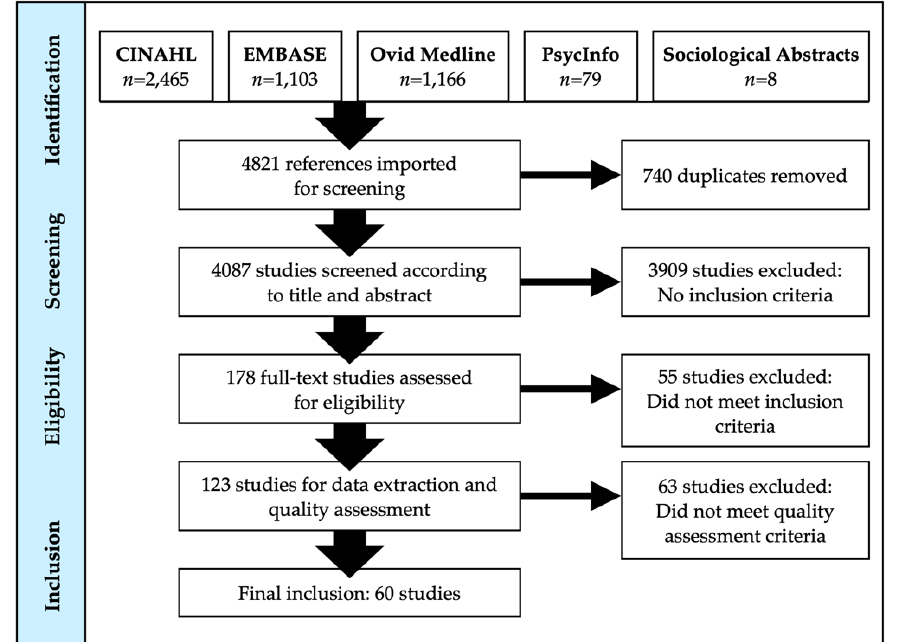
Figure 1. PRISMA diagram of English literature search results.